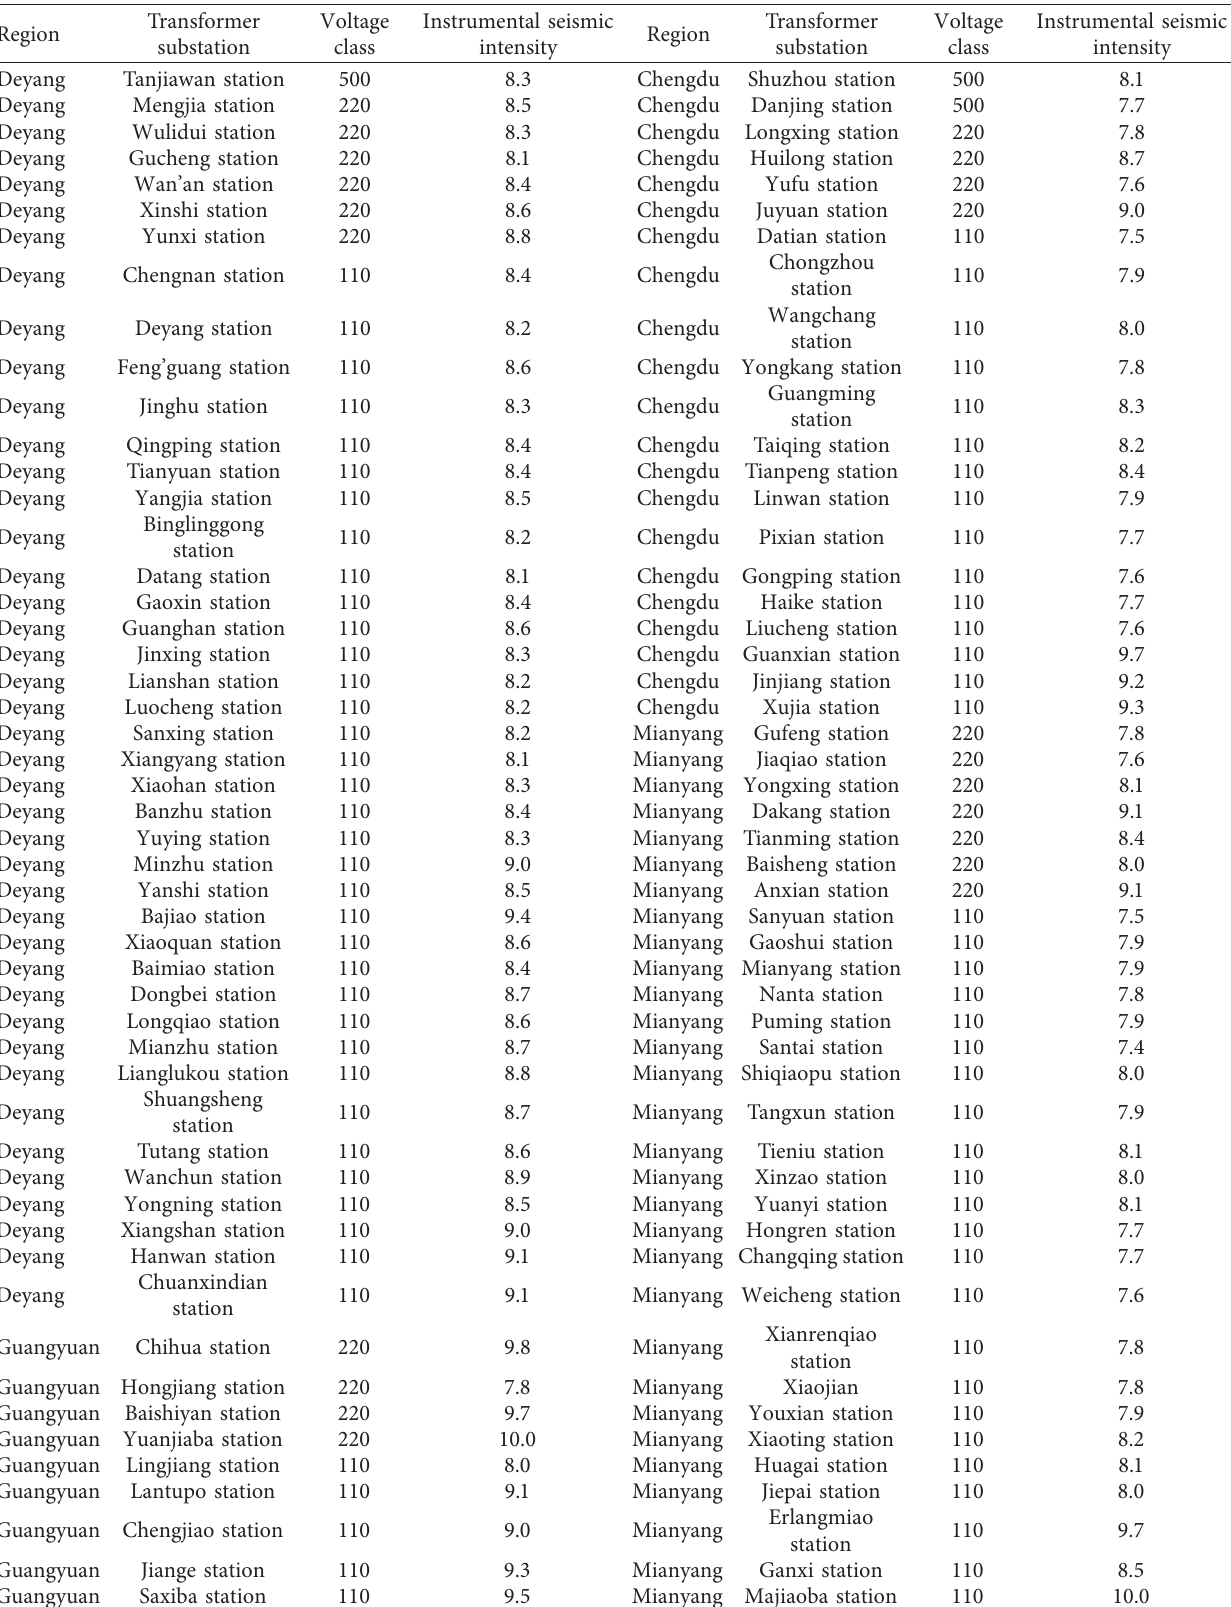
Table 1: Substations of 110kV and above and instrumental seismic